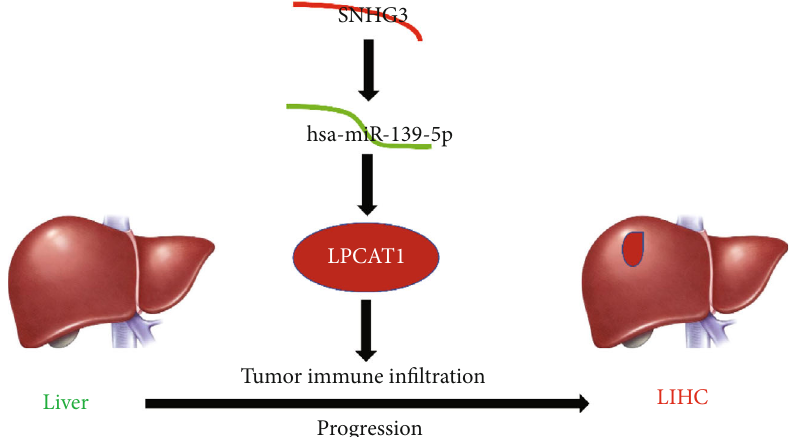
Figure 8: The model of the SNHG3-hsa-miR-195-5p-LPCAT1 axis in carcinogenesis of